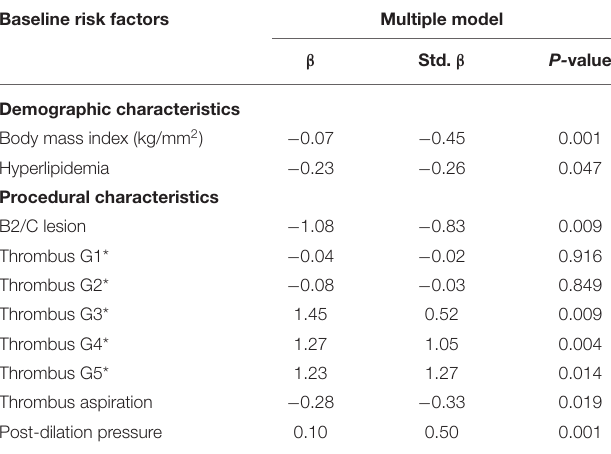
TABLE 5 | Independent risk factors of neointimal thickness ( n =